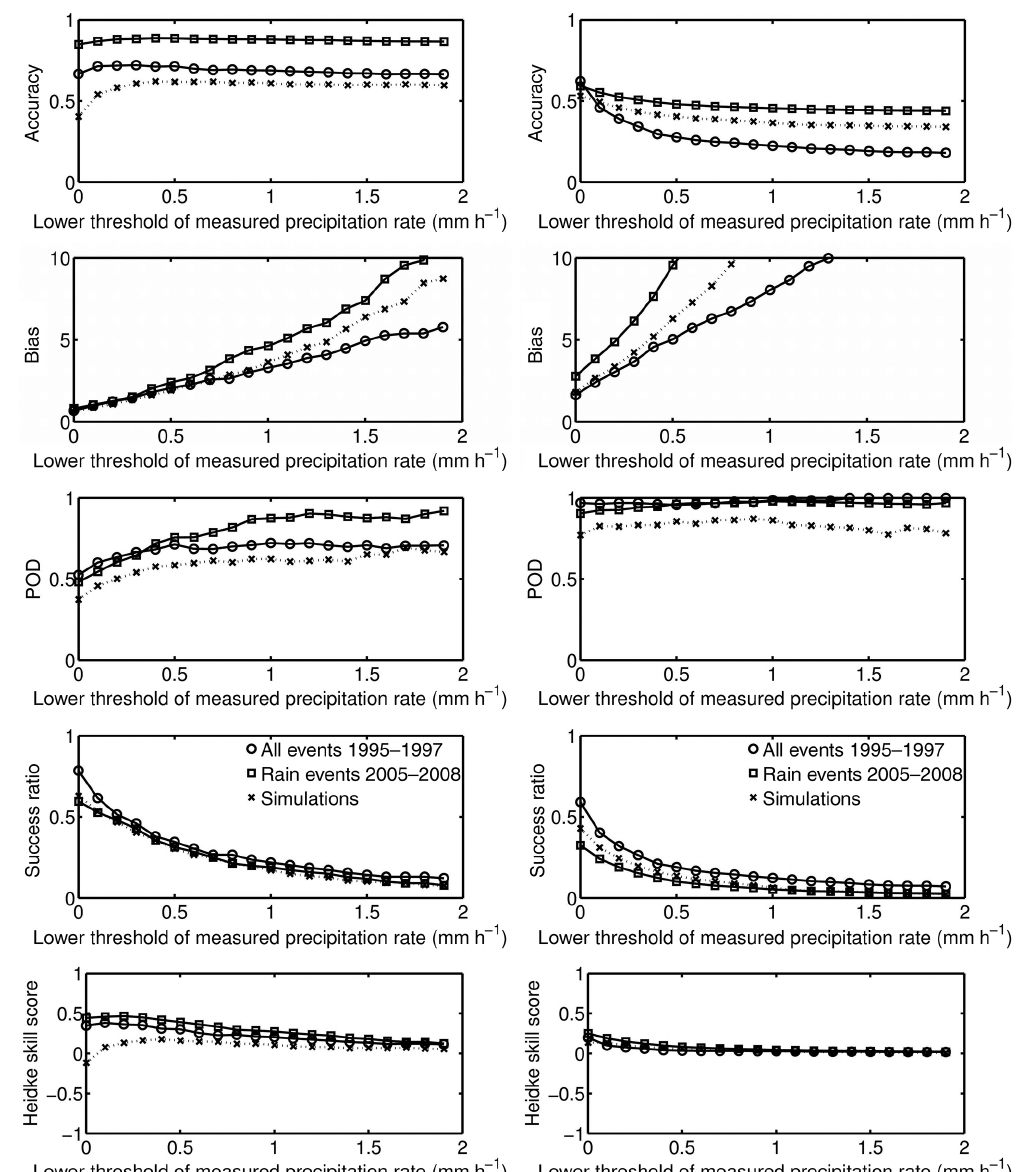
Figure 5. Accuracy, bias score, POD, success ratio and Heidke skill score (from top to bottom) against precipitation measurements for the period 2005–2008 (left HOAPS, right ERA-Interim) as a function of a lower threshold applied to the